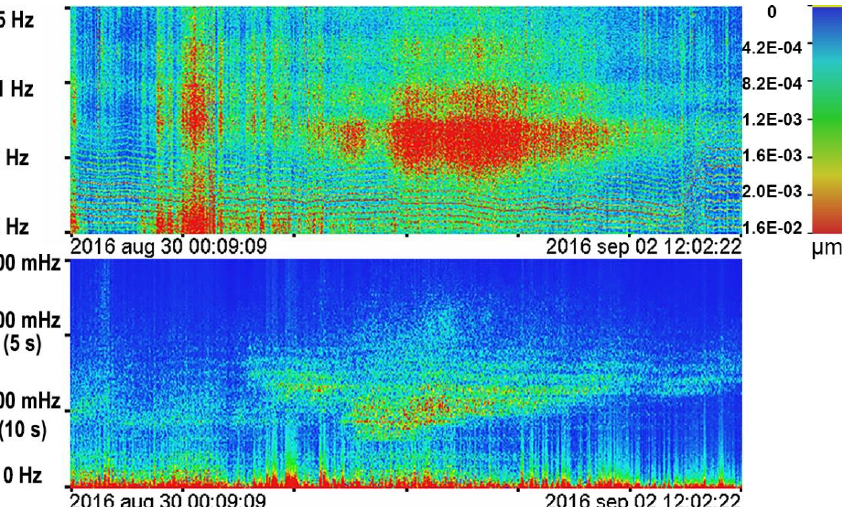
Figure 4. Dynamic spectrograms of laser strainmeter data during influence of Lionrock typhoon.